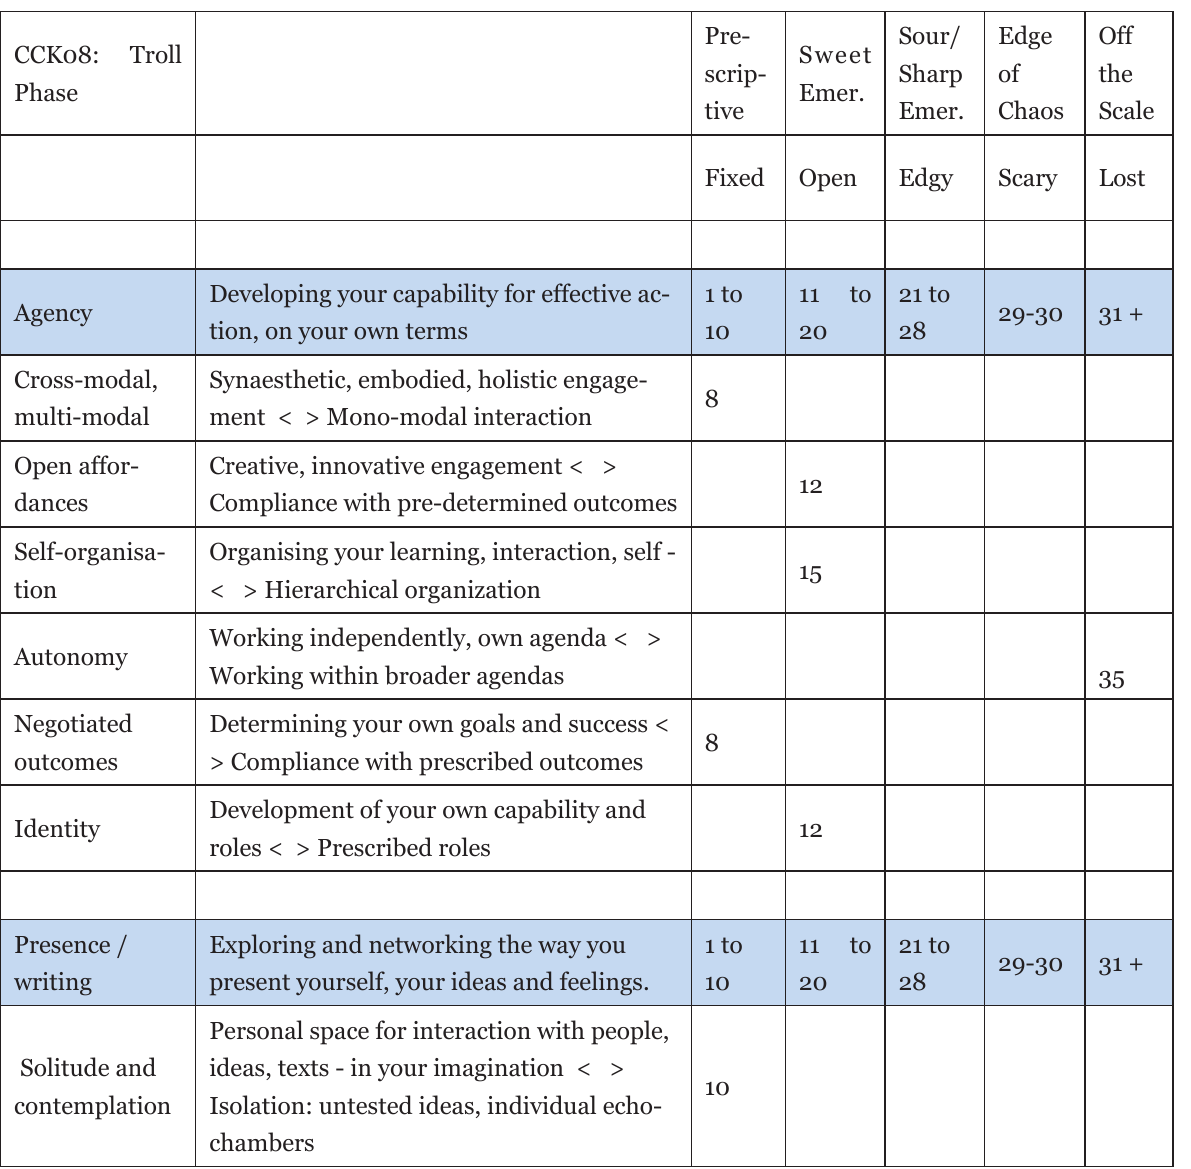
The Agency and Presence/Writing Clusters, Troll Phase of